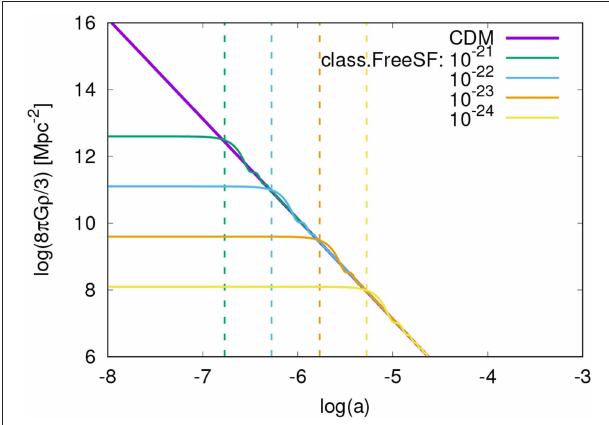
FIGURE 1 | The background solution of the SFDM density, for different values of the boson mass m a , in comparison with the case of CDM. The numerical solutions were obtained from the Boltzmann code CLASS.FreeSF that solves the polar form of the KG equation (2) discussed in section 2.1. The vertical dashed lines indicate the values of the scale factor a osc at the start of the rapid oscillations of the scalar field φ ; the values of a osc were obtained from the equivalent solutions of the Boltzmann code